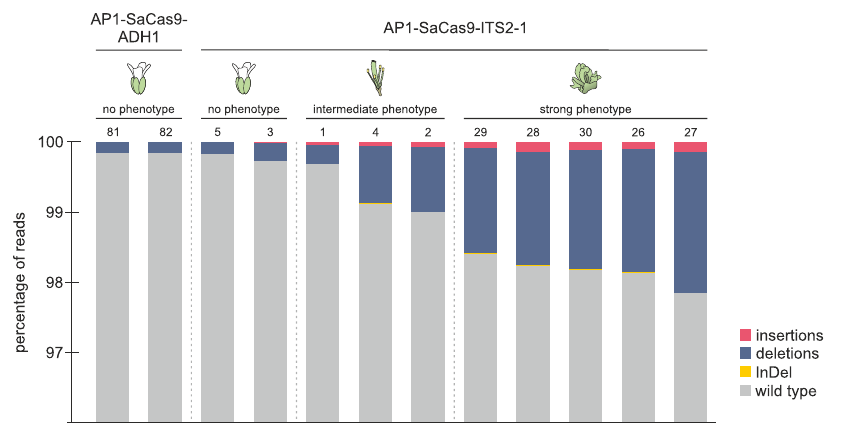
Fig. 4 Deep sequencing of fl oral CRISPR-Kill lines. The target site of ITS2-1 was analyzed via deep sequencing in fl oral tissue of two ADH1 control lines (#81 and #82) and ten ITS2-1 lines. The CRISPR-Kill lines were subdivided according to phenotype in ‘ no phenotype ’ (#5 and #3), ‘ intermediate phenotype ’ (#1, #4, and #2), and ‘ strong phenotype ’ (#26 to #30). The reads of the two ADH1 lines showed no repair events (gray), only also naturally occurring 1 bp- deletions (blue). In contrast, analysis of the CRISPR-Kill lines with a distinguishable phenotype revealed repair events like deletions (blue), insertions (red), and InDels (yellow), at the break site, with mutation frequencies linked to the severity of the phenotype. Source data have been deposited in SRA [accession: PRJNA726366].